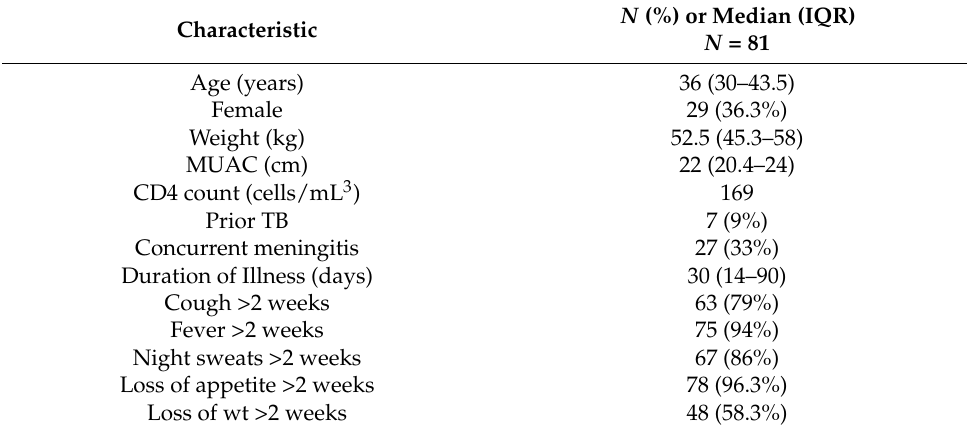
Table 1. Demographic and clinical characteristics among people living with HIV, presenting with critical illness and treated for tuberculosis. MUAC: mid-upper-arm circumference. TB: